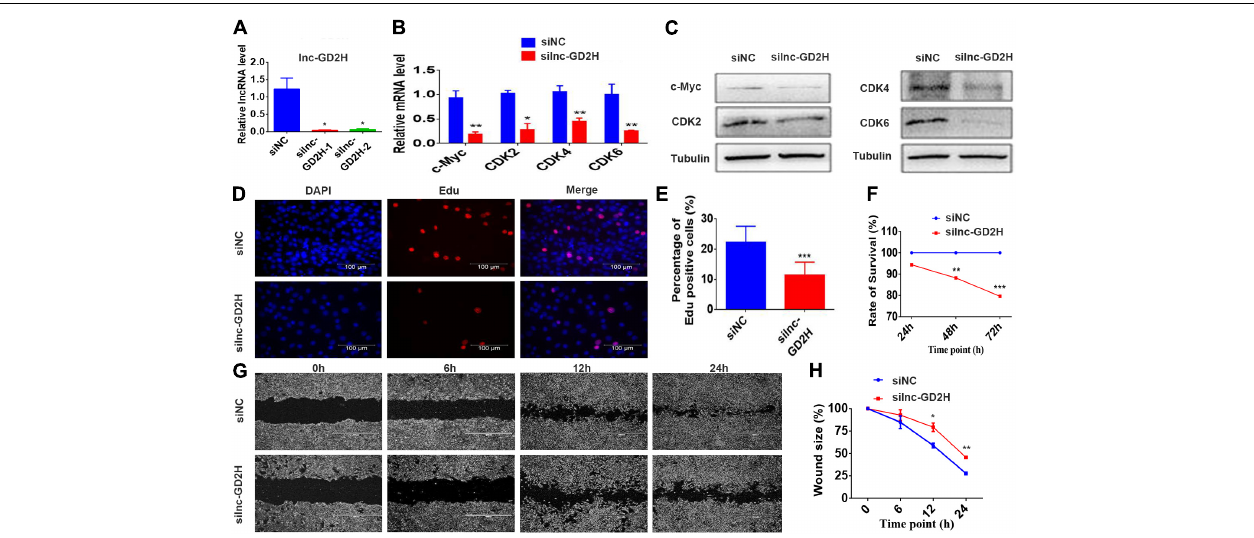
FIGURE 3 | Knockdown of lnc-GD2H inhibited proliferation and decreased c-Myc expression. (A) Relative lnc-GD2H expression level in C2C12 myoblasts expressing siNC or silnc-GD2H as confirmed using qPCR. (B,C) Expression levels of c-Myc, CDK2, CDK4, and CDK6 in lnc-GD2H-knockdown myoblasts as examined using qPCR and western blotting. (D) Cell proliferation was investigated using the EdU assay in lnc-GD2H-knockdown myoblasts. (E) Percentage of EdU-positive cells in lnc-GD2H-knockdown myoblasts. (F) Cell survival was determined using the CCK-8 assay in lnc-GD2H-knockdown myoblasts. (G) Wound healing assay of lnc-GD2H-knockdown myoblasts. (H) Percentage wound size after scraching was shown in lnc-GD2H-knockdown myoblasts. n = 3, * P < 0.05, ** P < 0.01, and *** P <